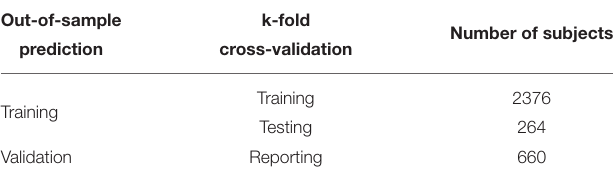
TABLE 1 | Data dimensions and